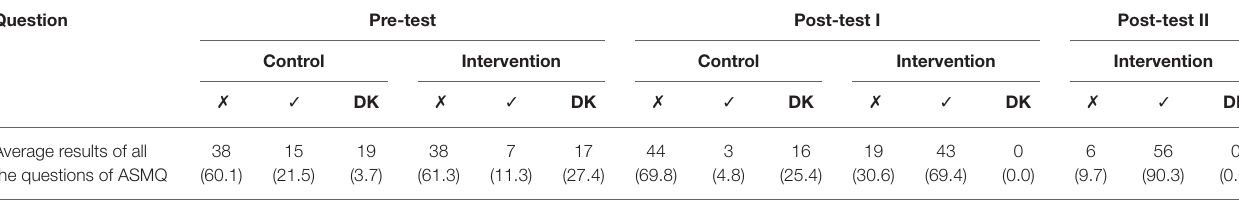
TABLE 6 | Asthma Self-management Questionnaire (ASMQ) summary of correct and incorrect responses.